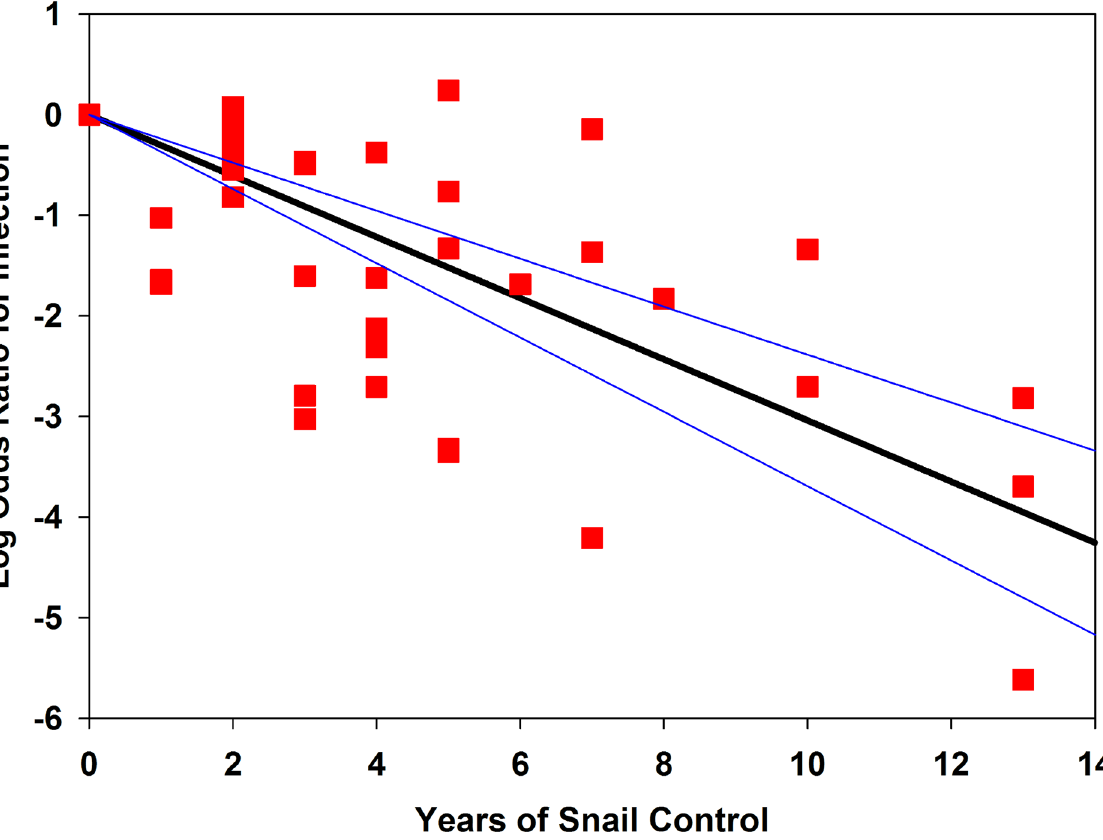
Fig 5. Meta-regression of Schistosoma infection prevalence log-odds ratio according to the duration of mollusciciding control. Red squares indicate the point estimates for individual studies, graphed as the log odds ratio of infection after mollusciciding (y axis) against the reported duration of snail control (x axis). The dark line indicates the best-fit regression line for the combined studies, anchored at zero effect at time 0. The thin lines indicate the 95% confidence band for the regression.